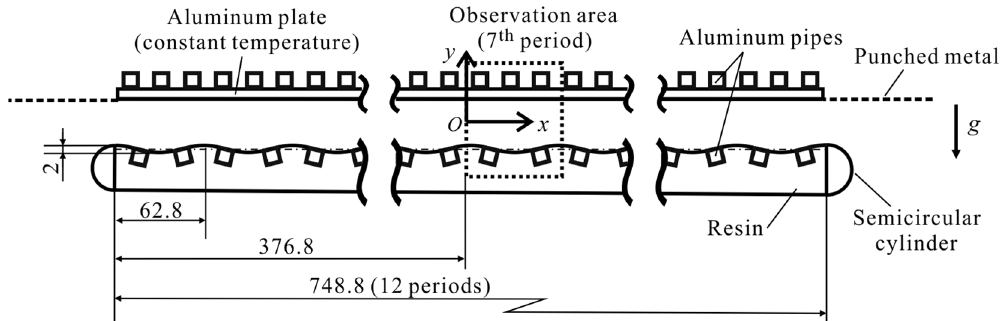
Figure 6. Sketch of the experimental apparatus (all dimensions are in mm) used for experiments C 1 and C 2. Both ends of the apparatus were closed in the experiments A and B . The upper plate remained the same in all experiments. The lower plate was replaced with an isothermal grooved plate for experiment A and with a smooth plate subject to periodic heating for experiment B . See text for